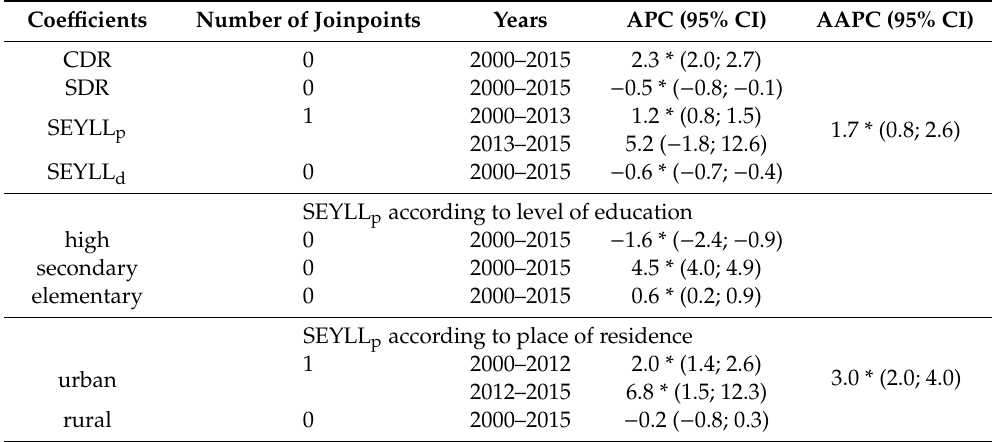
Table 2. Time trends of CDR, SDR, SEYLL p and SEYLL d due to prostate cancer in Poland in 2000–2015 (joinpoint regression